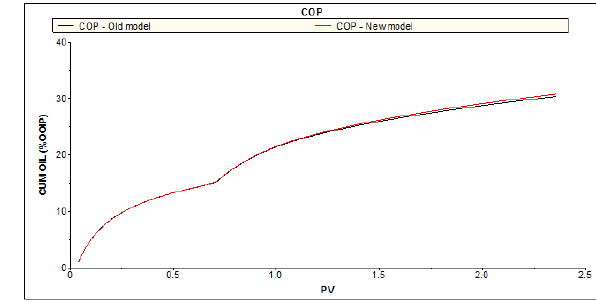
Figure 11: Comparison of oil recovery curves simulated using the currently used and the newly developed chemical compositional models for the waterflood and alkali flood part of the fractured block